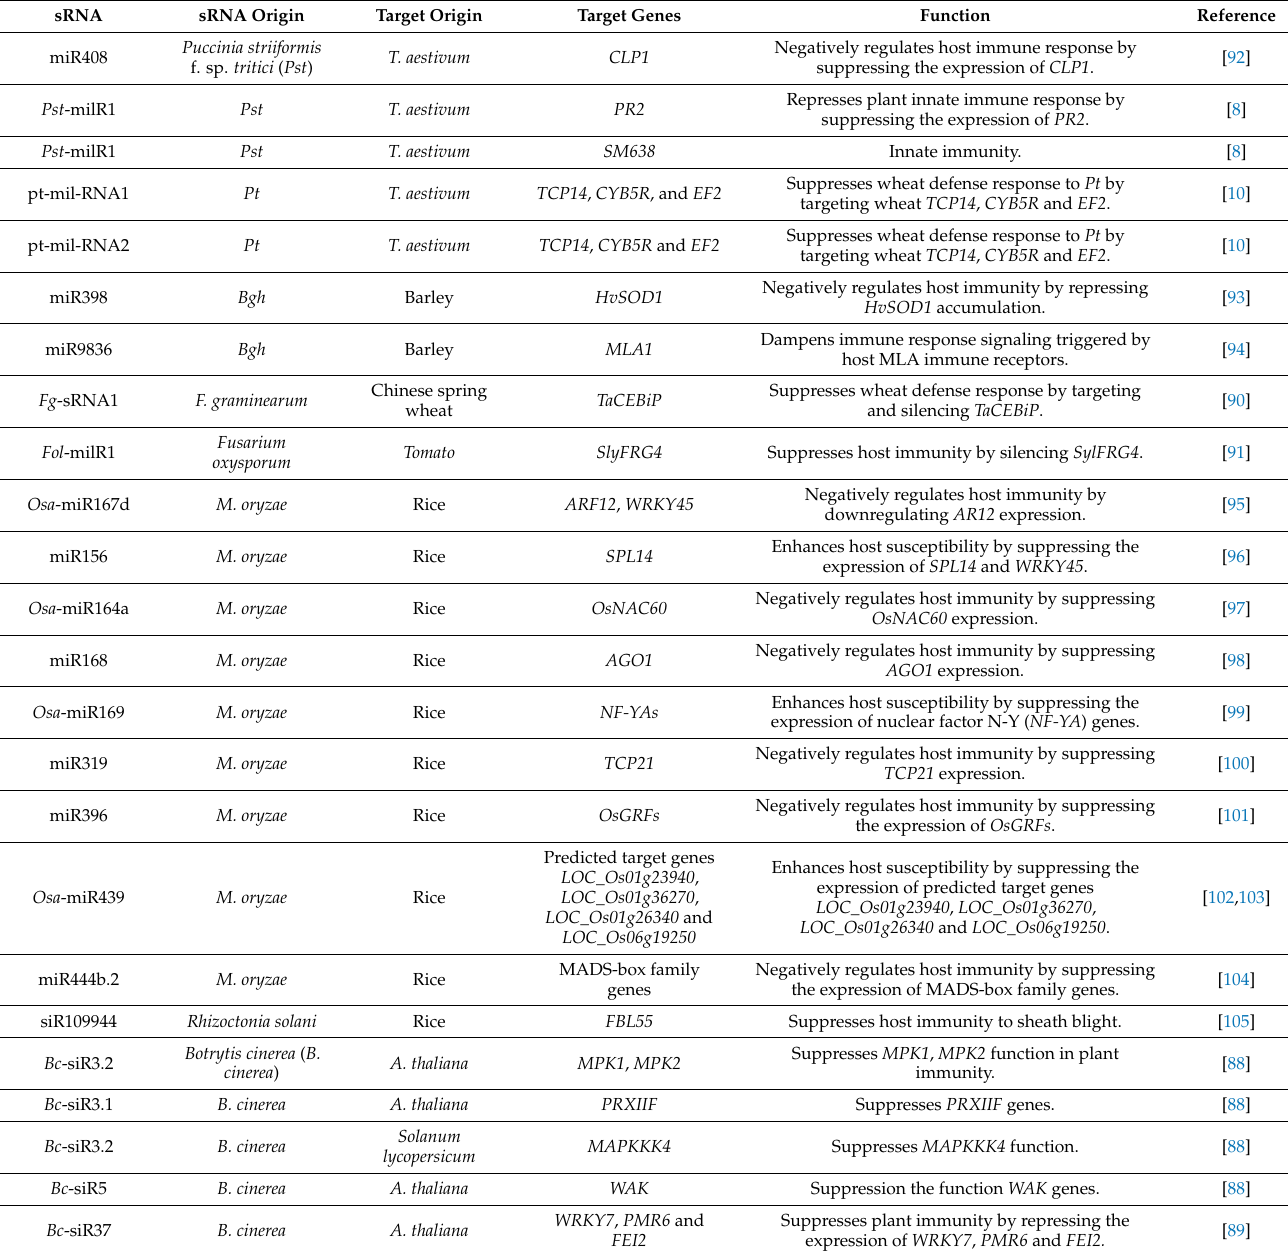
Table 2. Fungal sRNA effectors and their target genes in cross-kingdom